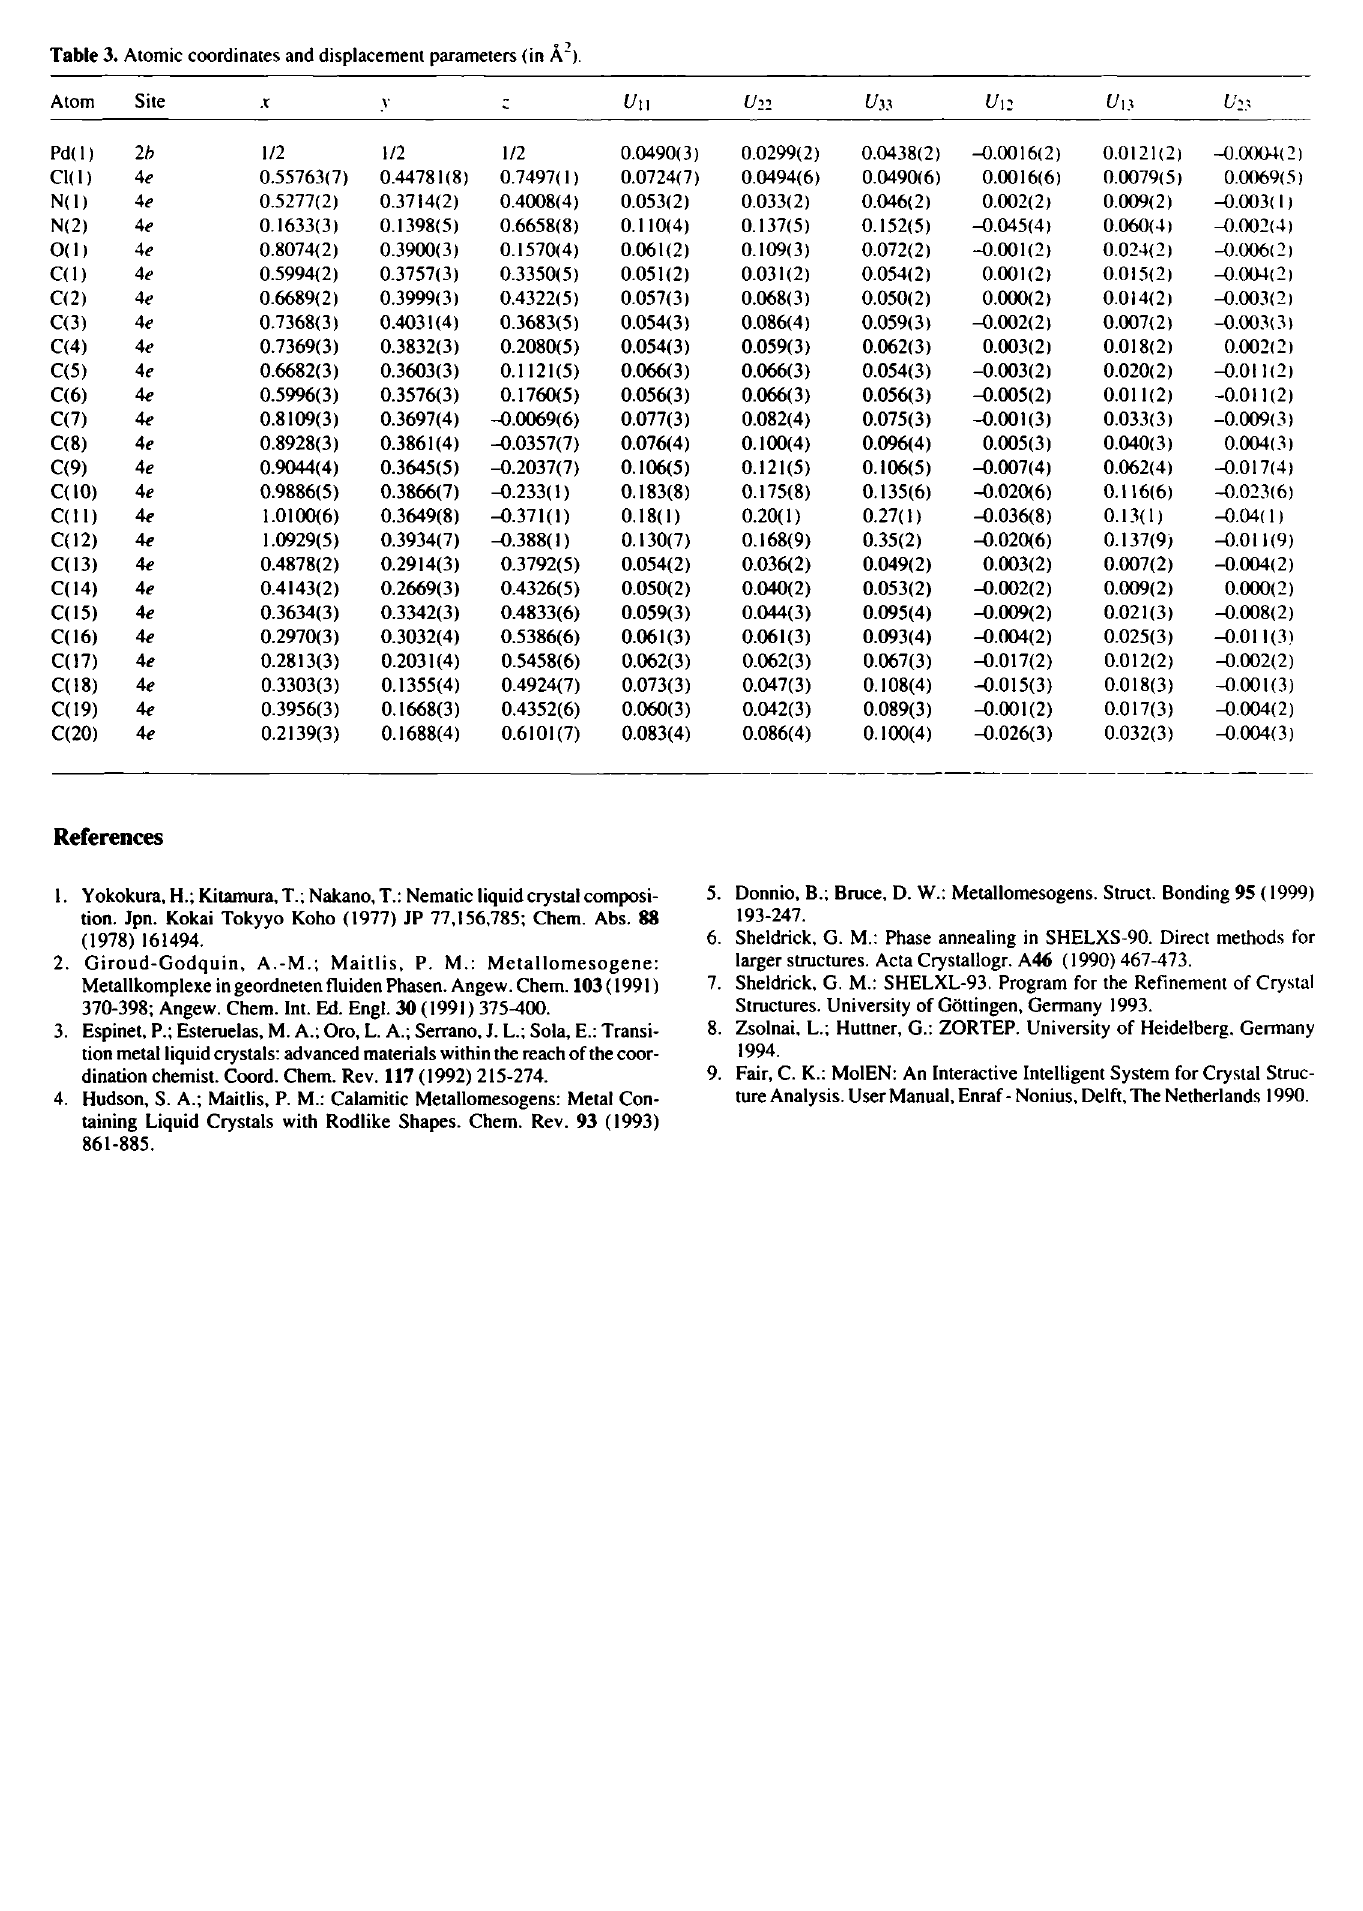
Table 3. Atomic coordinates and displacement parameters (in A 2